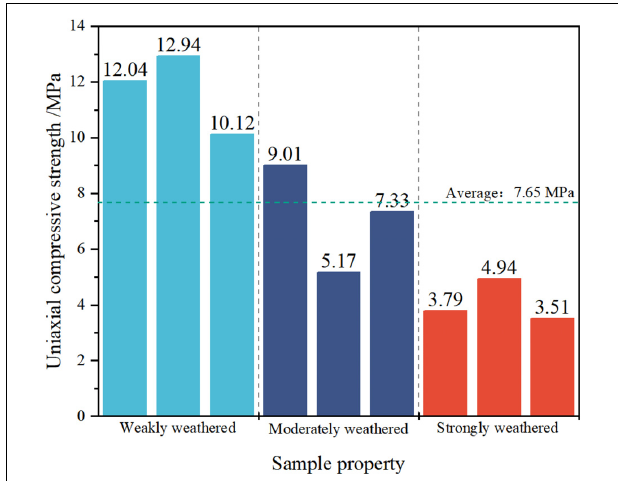
FIGURE 4 | Uniaxial compressive strength of the tested rock samples.